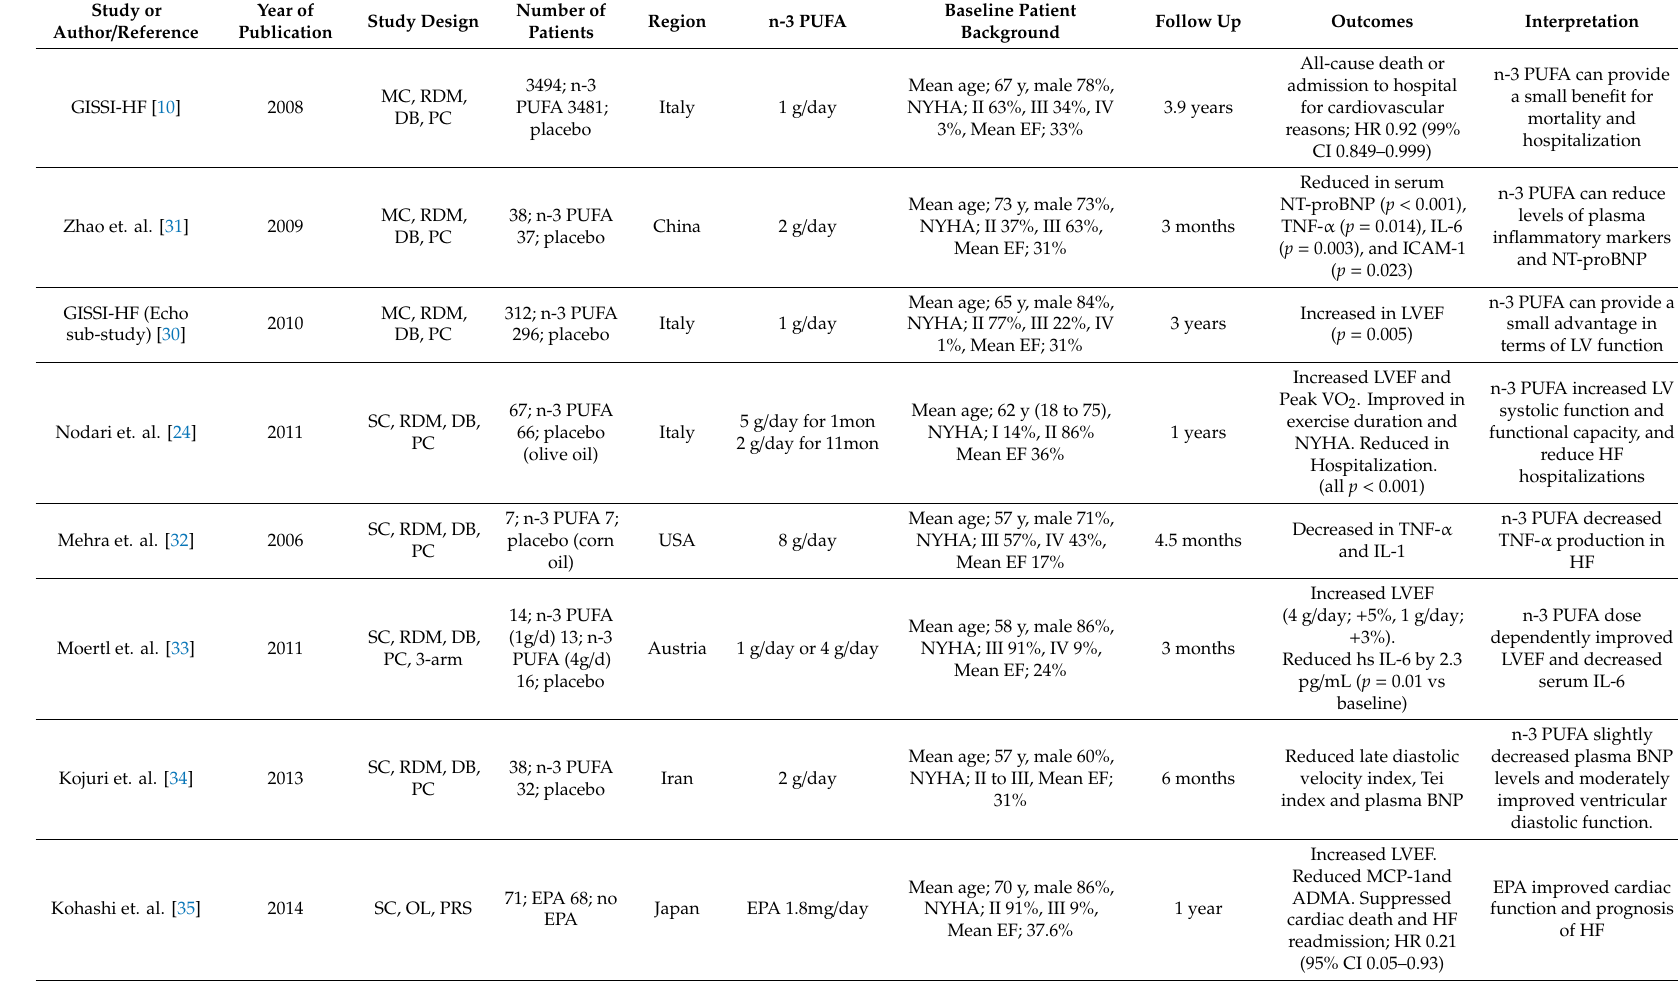
Table 2. Clinical trials for secondary HF